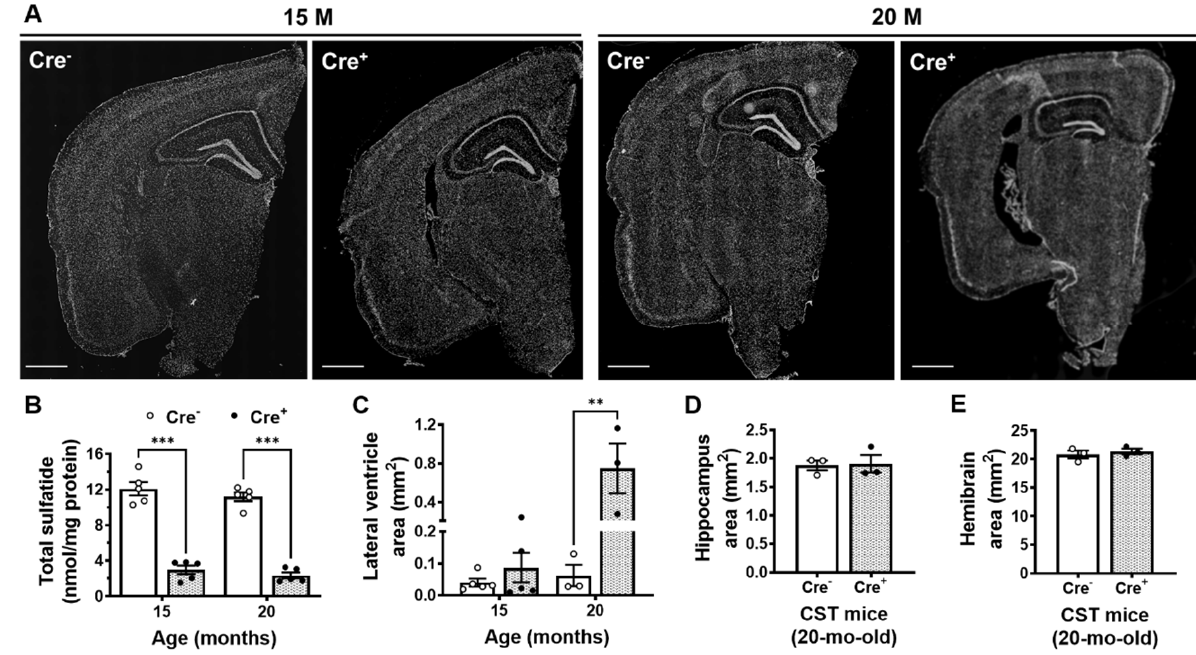
Figure 3. Adult-onset sulfatide deficiency leads to old age ventricular enlargement in the mammalian brain. ( A ) Representative DAPI-stained images of coronal brain sections from 15- and 20-month-old Cre + and Cre − mice following tamoxifen induction at 3 months of age. Scale bar: 1 mm. ( B ) Total sulfatide in cerebrum samples from Cre + and Cre − mice measured by MDMS-SL. Lateral ventricle ( C ), hippocampal ( D ), and whole hemibrain ( E ) areas from mouse brain sections. N = 3–5 mice/genotype. Each dot represents average data from 2–4 sections (Bregma − 1.8 to − 2) for each animal. Two-way ANOVA (Tukey) for ( A , B ) and unpaired two-tailed t -test for ( D , E ) (normality and equal variance were assumed/confirmed). ** p < 0.01, *** p < 0.001.